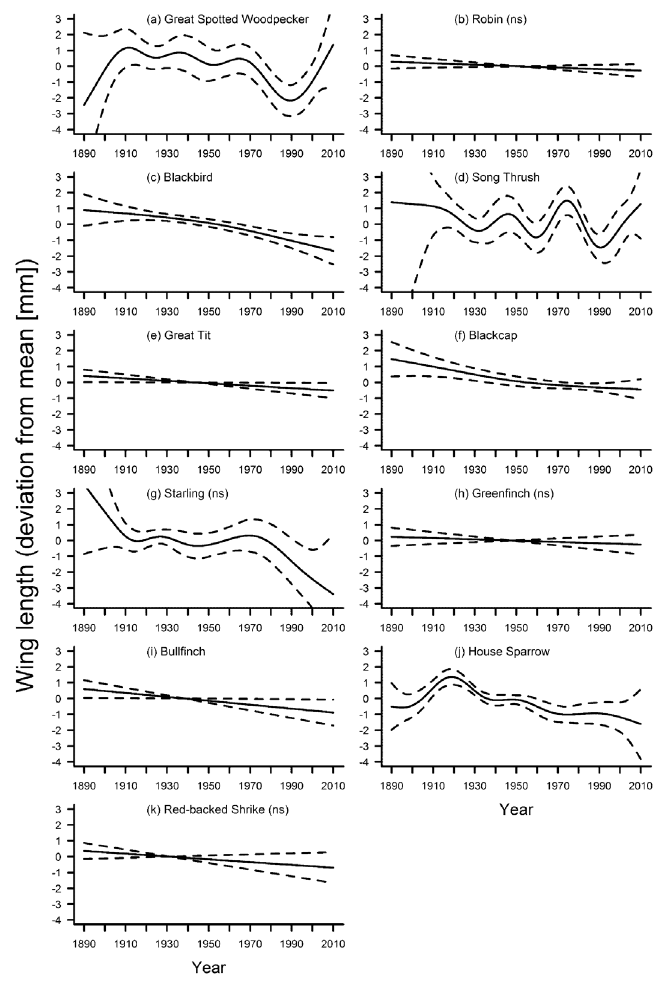
Figure 5. Fluctuations in wing length of eleven bird species in southern Germany between 1889 and 2010. Solid line – regression spline fit from the GAM; dashed lines – 95% confidence intervals. See methods for details. A p-value of . 0.05 is indicated with (ns) after the species name, see table 2 for exact p-values.